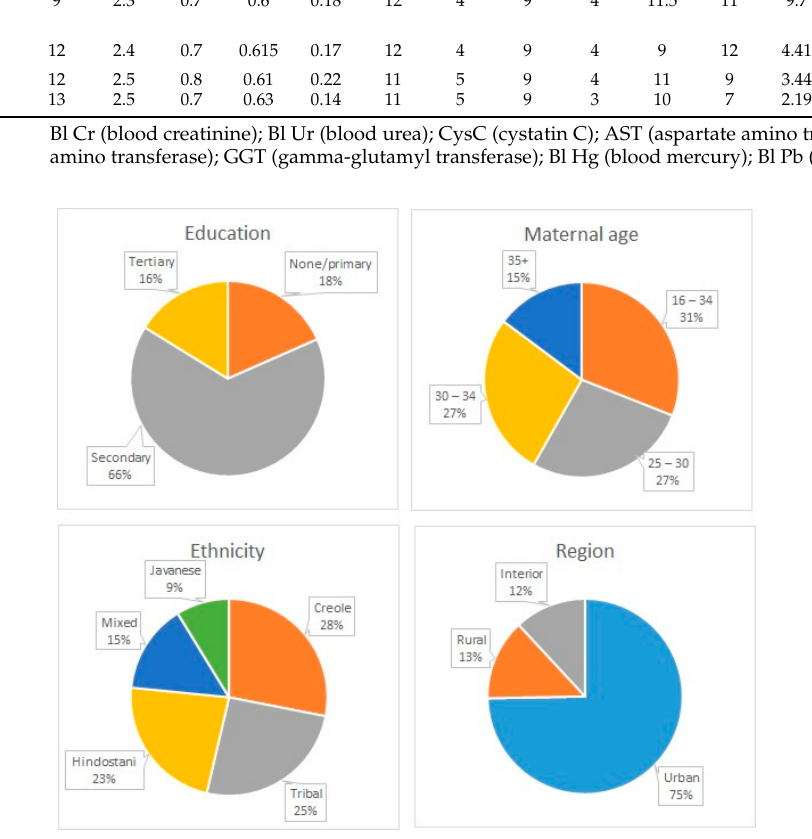
Figure 1. Maternal demographic data.